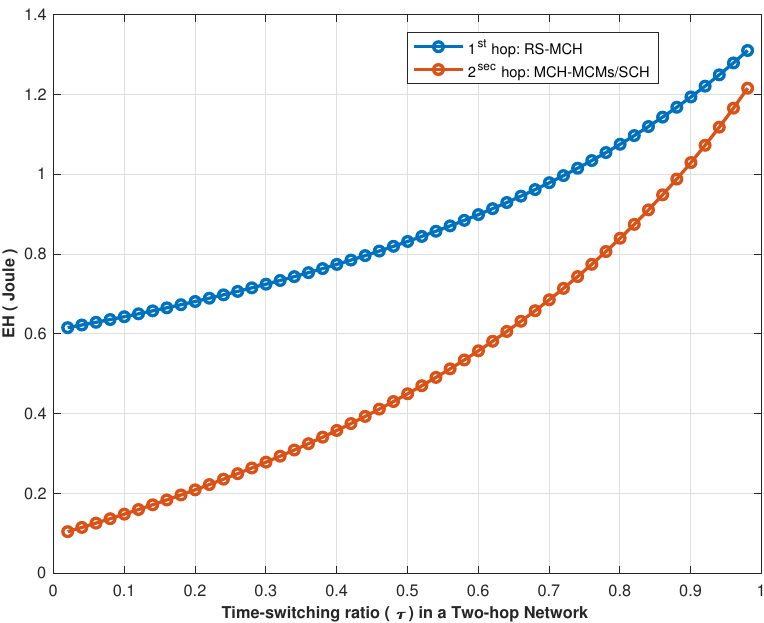
Figure 14. EH vs. time switching factor ( τ ) for a two-hop wireless network.